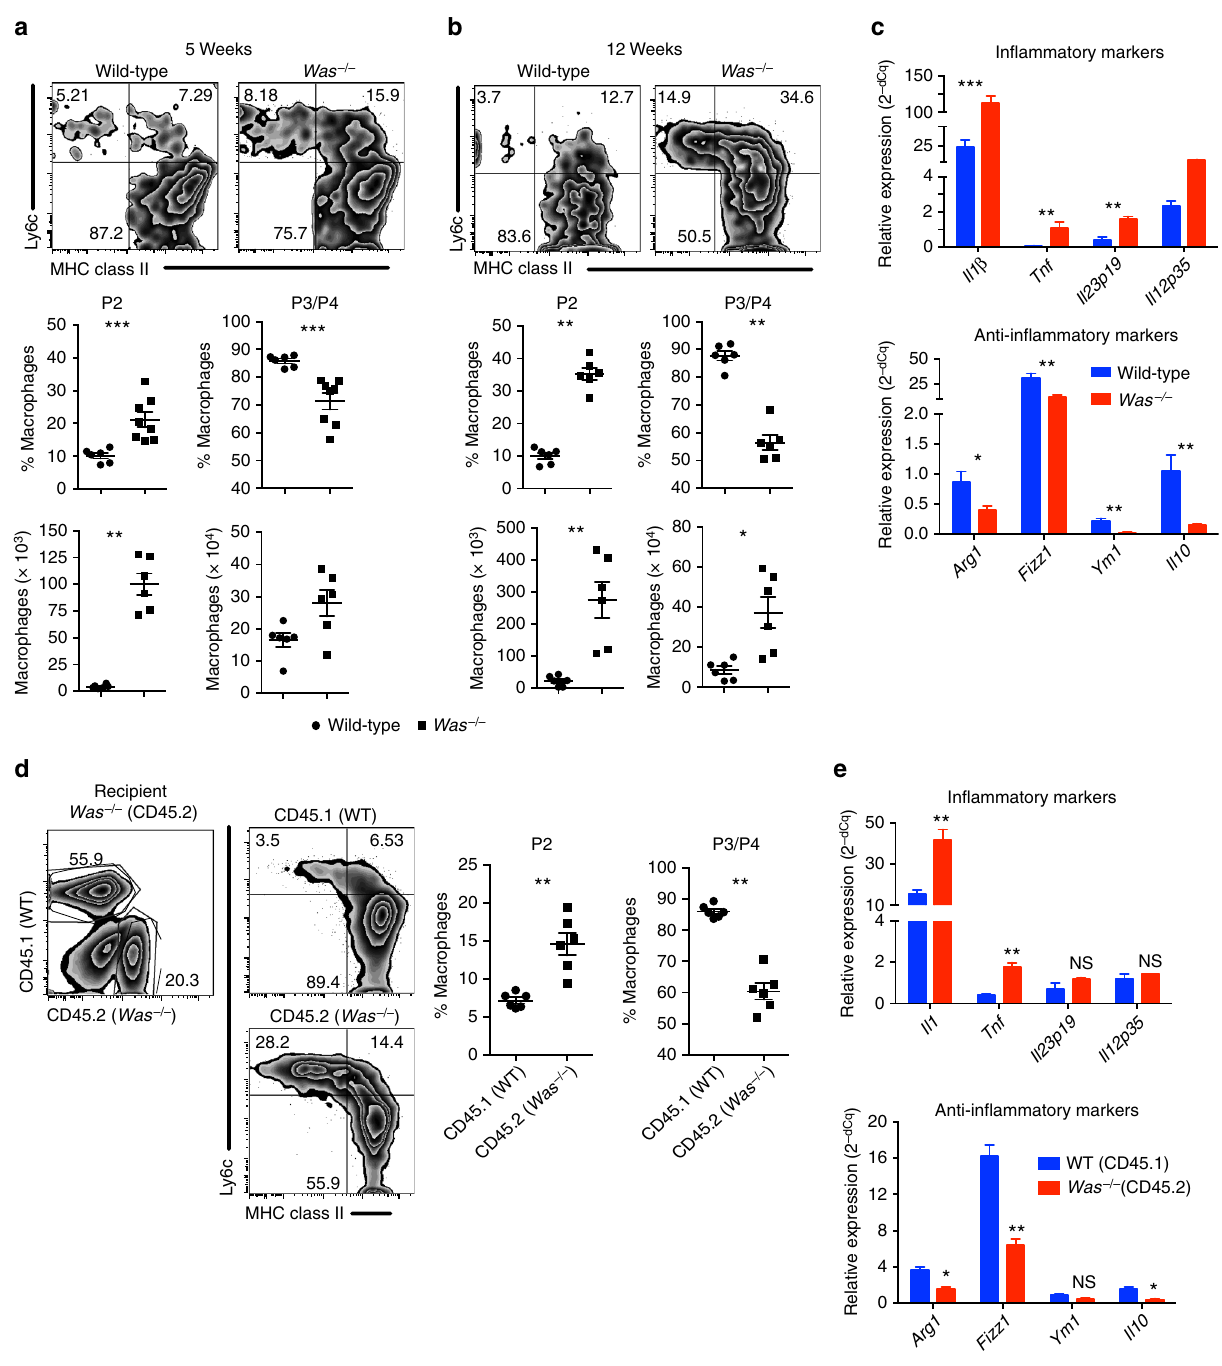
Fig. 1 Defective anti-in fl ammatory macrophage differentiation and function in the colon of Was − / − mice. Flow cytometric analysis of LP macrophage in mice at a 5 (WT n = 6; Was − / − n = 8) and b 12 (WT n = 6; Was − / − n = 6) weeks of age followed by quanti fi cation of pro- (P2) and anti-in fl ammatory (P3 + P4) subsets. Macrophages were gated as live CD45 + CD11b + CD103 - CD64 + cells. Data are cumulative of three independent experiments. *p < 0.05, * *p < 0.01, ** *p < 0.001 (Student ’ s t -test). c Expression of pro- and anti-in fl ammatory genes in sorted P3 + P4 macrophages (WT n = 12; Was − / − n = 12). P3 + P4 cells from three mice were pooled together. Data are cumulative of two independent experiments. *p < 0.05, * *p < 0.01, ** *p < 0.001 (Student ’ s t - test). d CD45.1 + (WT) and CD45.2 + ( Was − / − ) bone marrow cells were transferred at the ratio of 1:1 into lethally irradiated CD45.2 + Was − / − recipient. LP macrophage was analysed after 10 weeks. FACS plot shows the gating strategy. Graph shows the quanti fi cation of P2 and P3/P4 cells in the WT ( n = 6) and Was − / − ( n = 6) compartment of recipient mice. Data are representative of two independent experiments. *p < 0.05, * *p < 0.01, ** *p < 0.001 (Student ’ s t -test). e Expression of pro- and anti-in fl ammatory genes in sorted P3 + P4 macrophages in mice ( n = 8). P3 + P4 cells from two mice were pooled together. *p < 0.05, * *p < 0.01, ** *p < 0.001, NS, not signi fi cant (Student ’ s t -test). All graphs shows mean ±